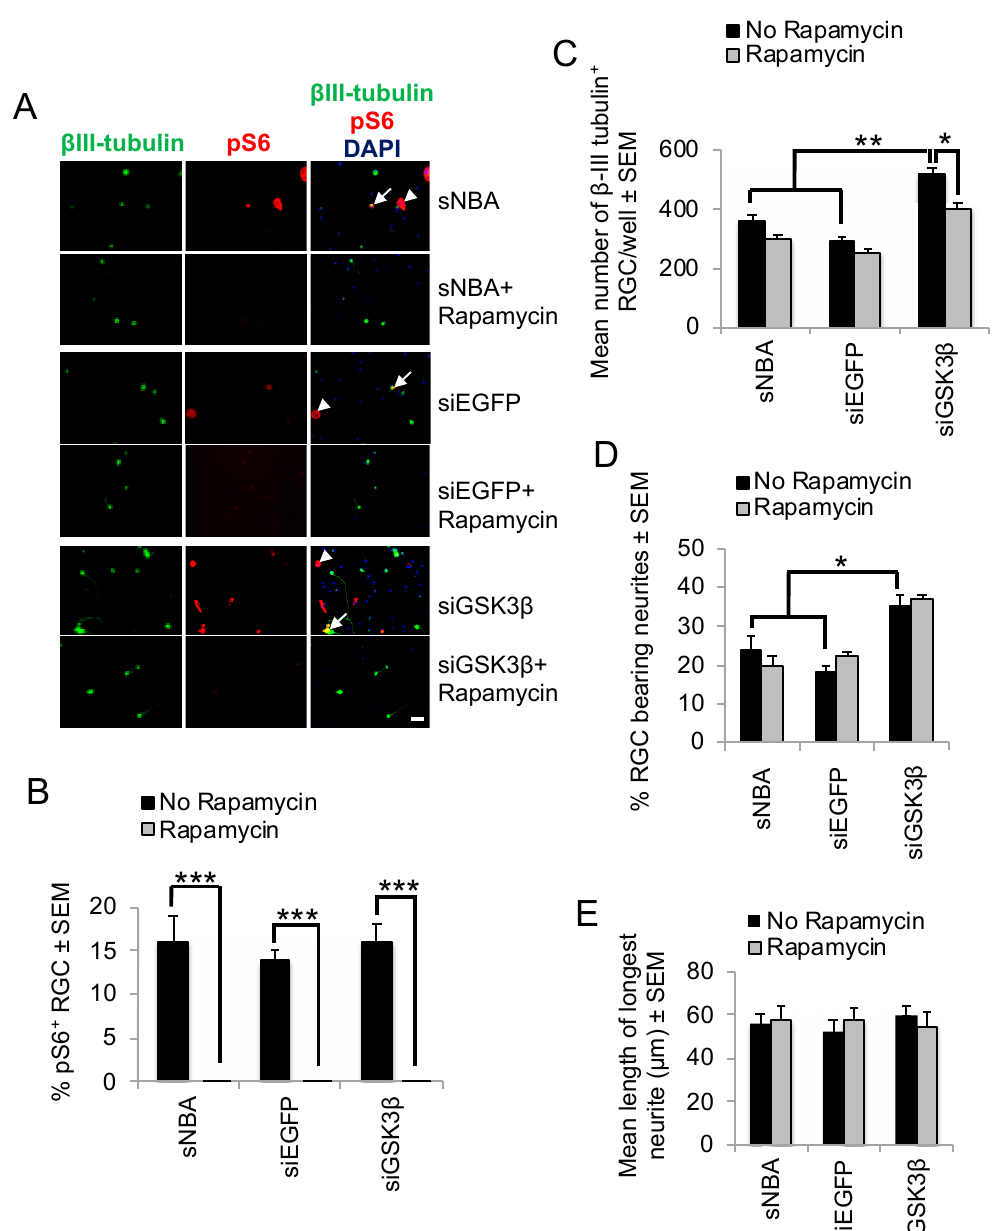
Figure 5. Effects of Rapamycin on siGSK3 β -mediated RGC survival and mTORC1 activity in vitro. ( A ) Representative retinal cultures established five days after ONC in vivo to activate retinal glia, treated for three days with sNBA, siEGFP, and siGSK3 β in the presence and absence of the mTORC1 inhibitor Rapamycin and immunostained for β III-tubulin (green) and pS6 (red), with DAPI (blue) as a nuclear counterstain. Note that pS6 is detected both in β III-tubulin + RGC (long arrows) and β III-tubulin − cells (short arrows) and the abolition of pS6 immunostaining in the presence of Rapamycin. ( B ) The % of RGC exhibiting pS6 immunoreactivity indicated abolition of pS6 expression in the presence of Rapamycin, but there was no significant effect of siGSK3 β on the proportion of pS6 + RGC (* = p < 0.05, ** = p < 0.01, *** = p < 0.001). ( C ) Quantification of the number surviving β III-tubulin + RGC after treatment with siGSK3 β in the presence of Rapamycin shows that RGC survival is significantly enhanced. (Scale bar in A = 20 µm; ** = p < 0.01). ( D ) Quantification of the % RGC bearing neurites and ( E ) length of the longest RGC neurite are both significantly enhanced after siGSK3 β treatment, but this effect was unaffected by Rapamycin. n = 2 wells/treatment, 3 independent repeats (total n = 6 wells/treatment).